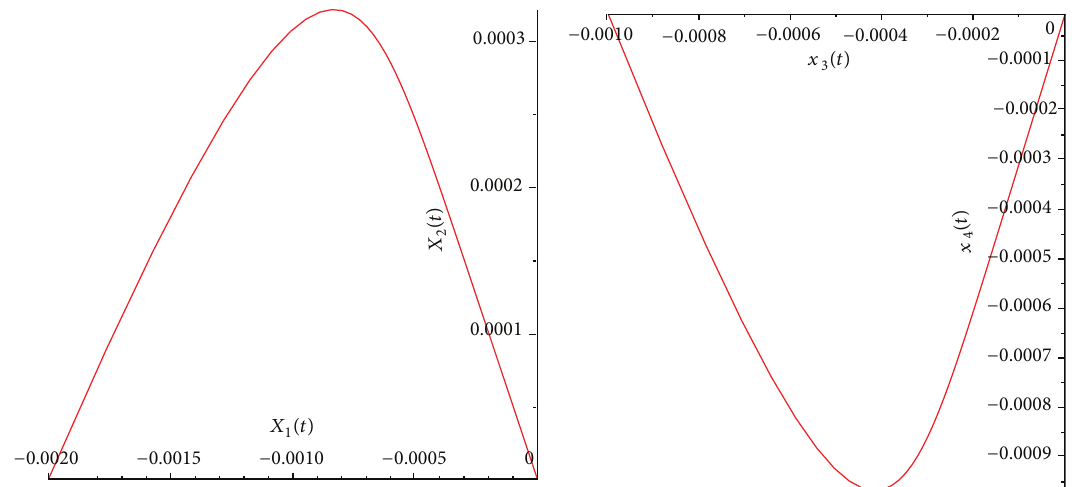
Figure 3: Trajectory projection starting from (𝑥 1 ,𝑥 2 , 𝑥 3 , 𝑥 4 ) = (−0.002, 0,−0.001, 0) converges to the E.S. when (𝛿 1 ,𝛿 2 ) = (−0.3,−0.3) .